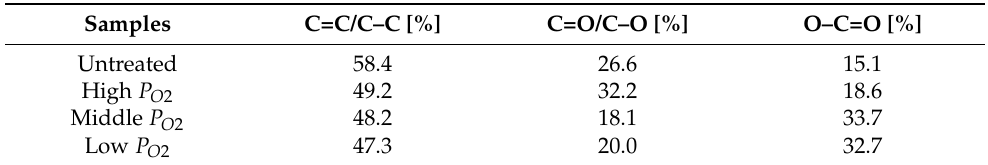
Figure 1. C1s X-ray photoelectron spectra of ( a ) untreated and vacuum-ultraviolet-treated films of woody carbon material under ( b ) high P O 2 , ( c ) median P O 2 , and ( d ) low P O 2 . Table 2. Chemical components of untreated and vacuum-ultraviolet-treated films of woody carbon material calculated from C1s X-ray photoelectron